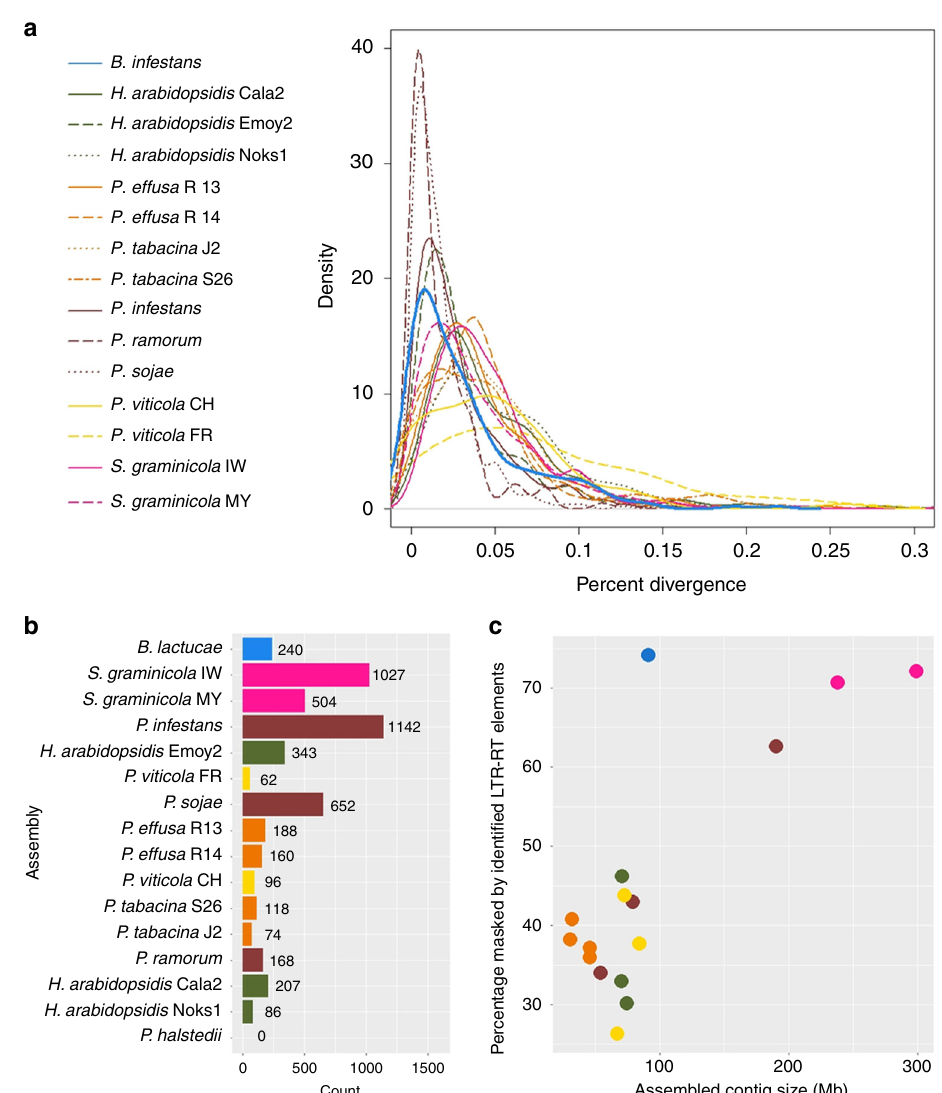
Fig. 2 Comparative long terminal repeat retrotransposon (LTR-RT) analysis. a Comparison of percent divergence of LTR elements in 15 oomycete assemblies. Distribution of percent divergence of LTR elements is shown for 12 downy mildew ( B . lactucae , H . arabidopsidis , P . effusa , P . tabacina , P . viticola , and S . graminicola ) and three Phytophthora ( P . infestans , P . ramorum , and P . sojae ) assemblies. Statistics of these assemblies are included in Supplementary Table 2. LTR elements of B . lactucae are less diverged than elements in other downy mildew assemblies. b Counts of unique LTR-RTs harvested and annotated from each assembly surveyed. Larger assemblies (panel c ) are observed as having higher counts of LTR-RTs. Bars are ordered by the percent of the assembly masked displayed in panel c . Only partial elements could be found for P . halstedii . c Scatterplot demonstrating the percentage of the assembly sequence that is masked by annotated LTR-RTs and partial elements. Colors are retained from panel b . The percentage of the assembly masked increases with assembly size. B . lactucae is an outlier as it has a medium assembly size, but the highest masked percentage. Source data for all panels are provided in the Source Data fi